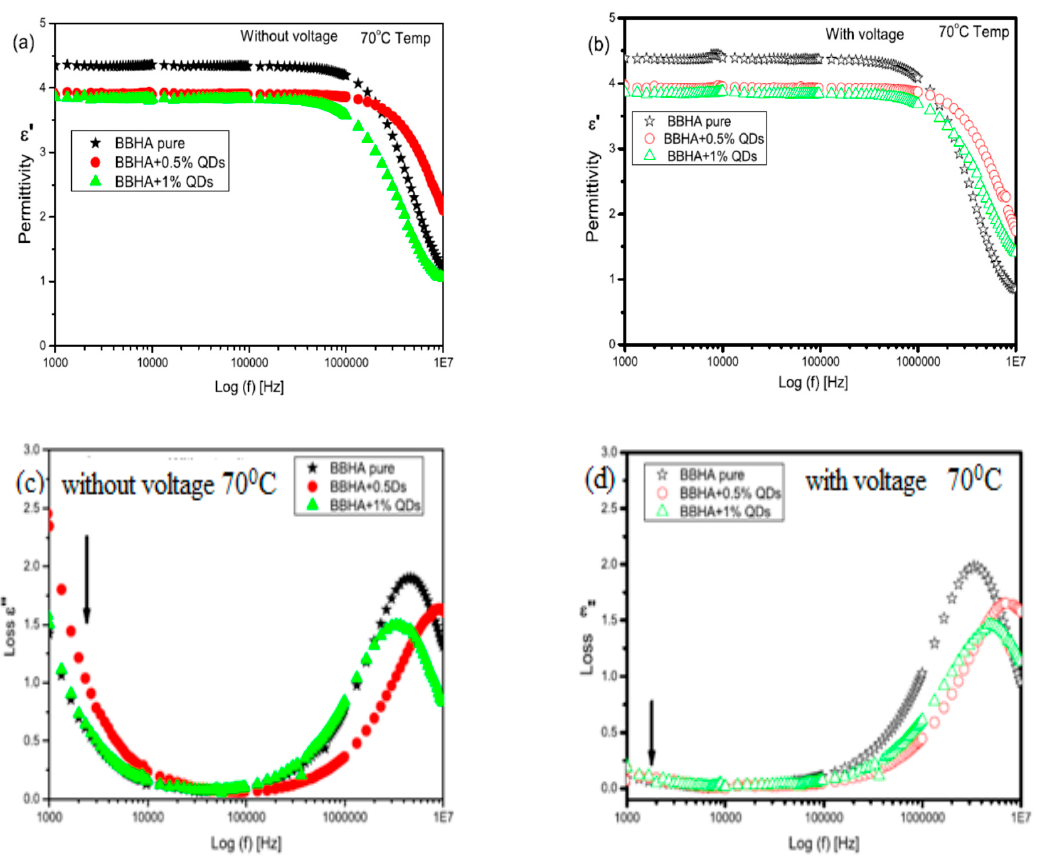
Figure 8. Variation of dielectric permittivity ( a , b ) and dielectric loss ( c , d ) of pristine and QDs (size Figure 8 Variation of dielectric permittivity (( a ), ( b )) and dielectric loss (( c ), ( d )) of pristine and QDs 8.2 nm) dispersed nematic BBHA at fixed temperature 70 ◦ C as a function of frequency, applied bias, (size 8.2 nm) dispersed nematic BBHA at fixed temperature 70 °C as a function of frequency, applied and QDs concentrations for the planar aligned cells [16]. bias, and QDs concentrations for the planar aligned cells [16].